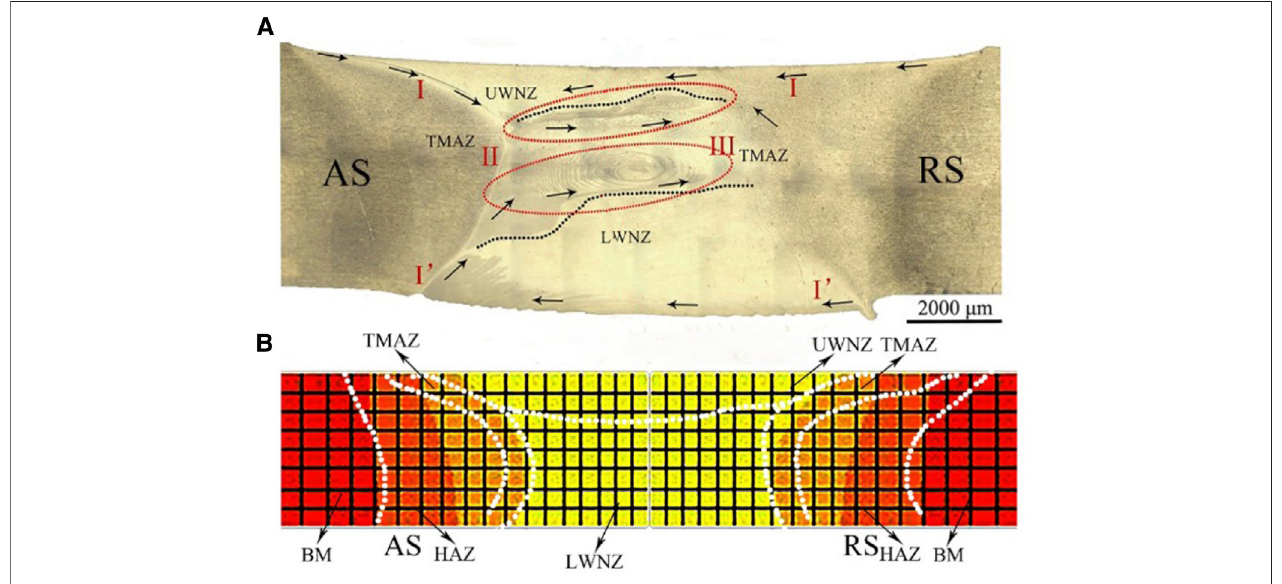
FIGURE 13 | Comparison of (A) experimental results and (B) temperature distribution cloud map at welding quasi-steady state.